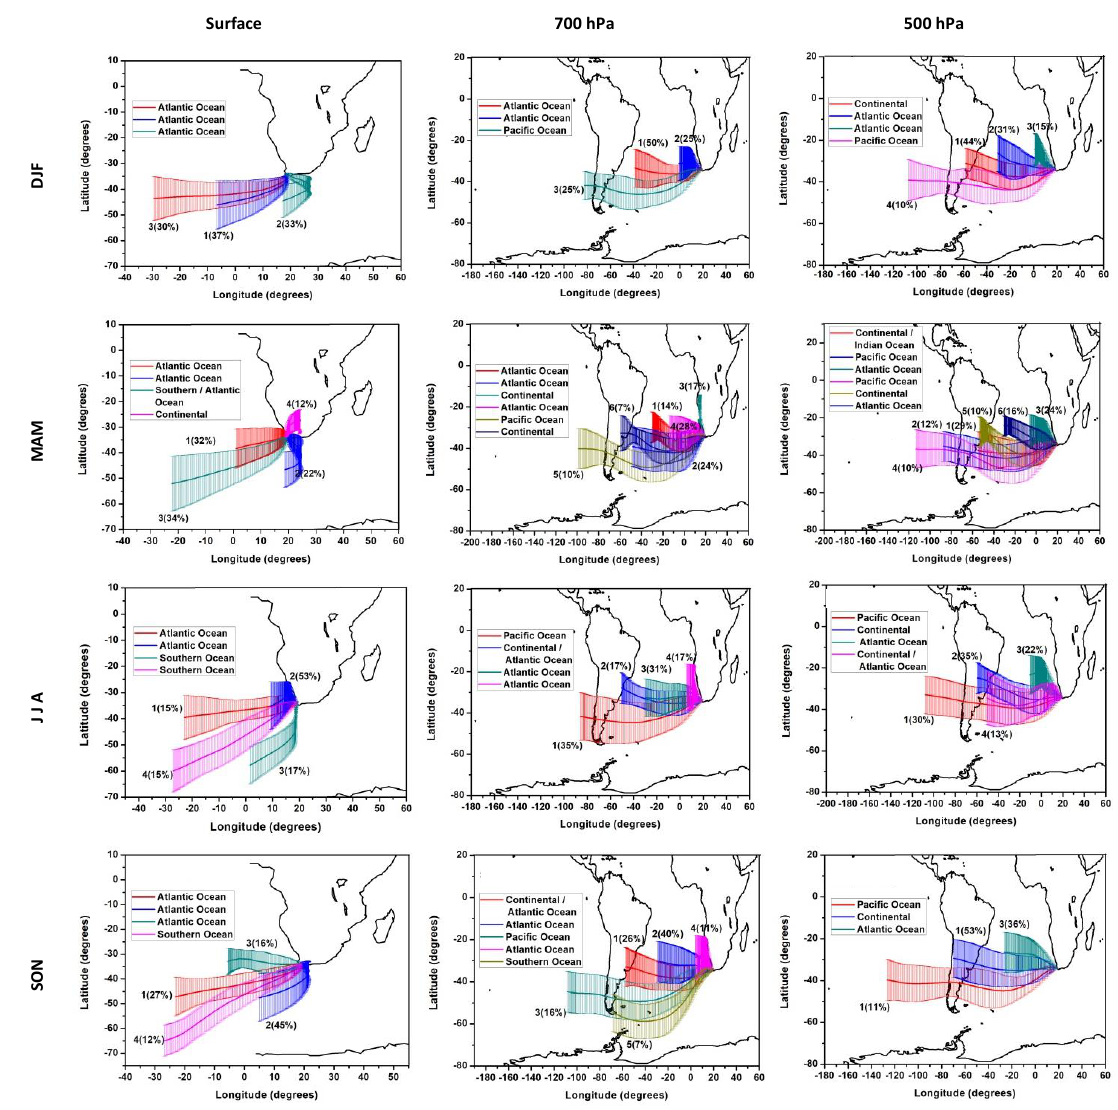
Figure 6. Seasonal 5-day backward trajectories illustrating air transport with its frequency impacting on CO 2 mixing ratios at the surface, above 3400, and 5500 m stable layers in the Cape Town area. From the ( top ) to the ( bottom ) row is the seasonal change from DJF to SON, while the ( left ), ( middle ), and ( right ) columns represent the atmospheric layers at the surface, above 3400, and 5500 m stable layers, respectively.